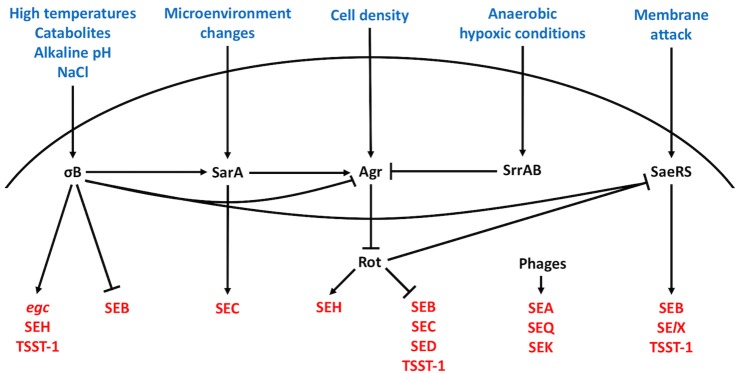
Regulation of staphylococcal enterotoxins. Harsh bacterial growth conditions, changes in the bacterial microenvironment, high cell density, hypoxia, and membrane changes direct enterotoxin expression through the alternative sigma factor, SarA protein family, Agr quorum sensing system, SrrAB protein, and SaeRS two-component system, respectively. The excitatory and inhibitory action of these systems on the other regulators and enterotoxins are summarized. Arrowheads represent upregulation and bars downregulation.